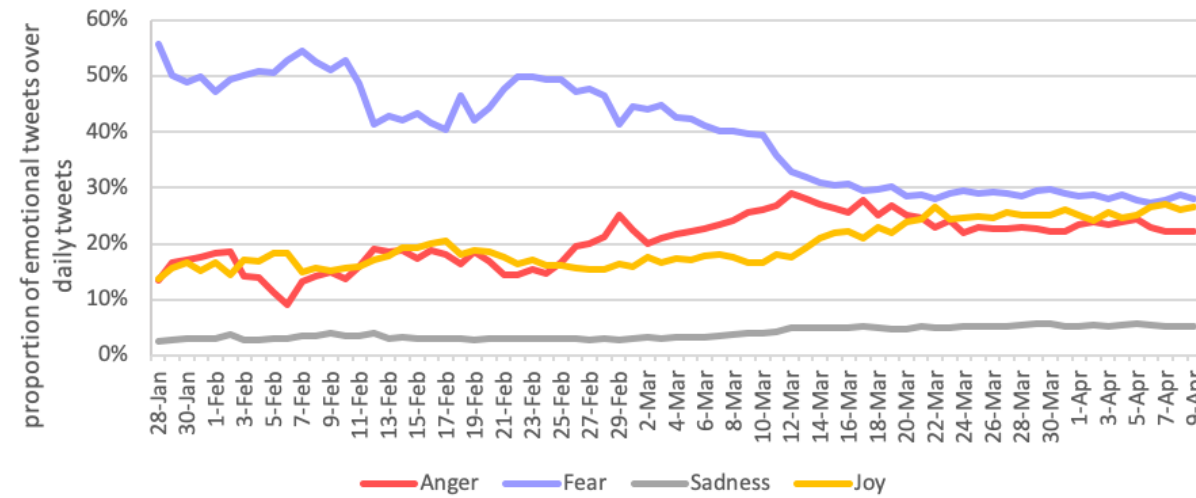
Figure 1. Emotions trends during the early stages of the COVID-19 pandemic.